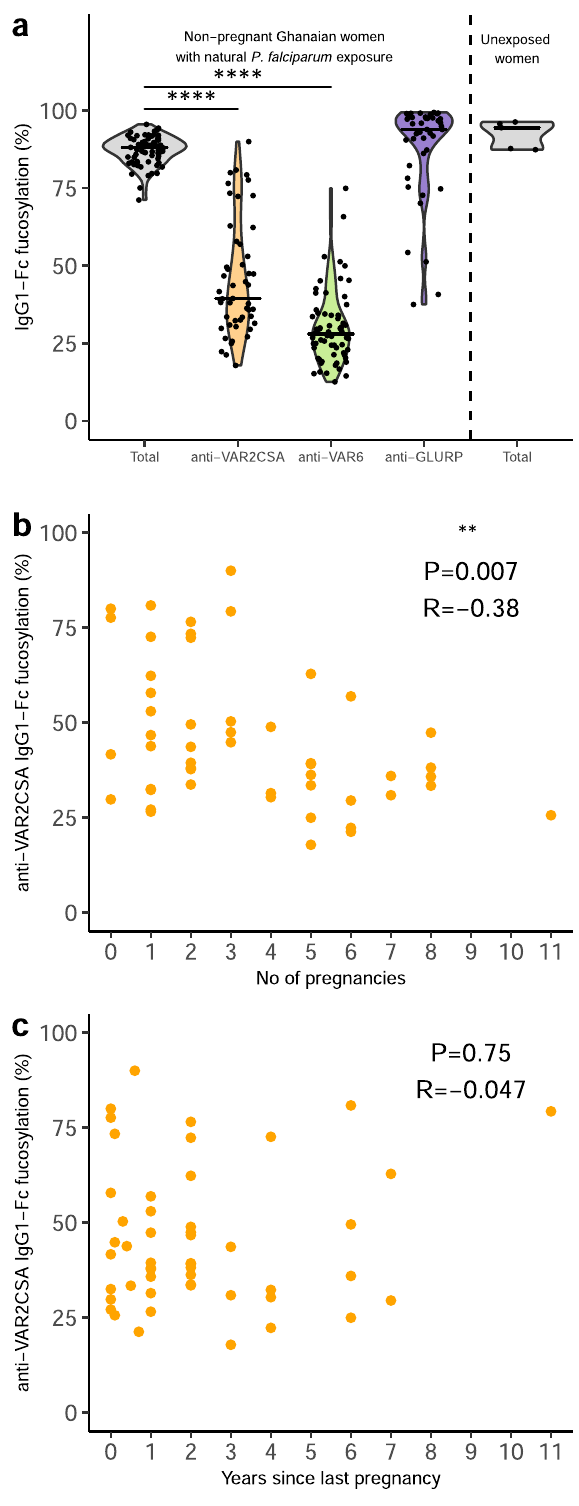
Fig. 3 Fc fucosylation levels of VAR2CSA-specifc IgG is temporally stable. a Fc fucosylation levels of total plasma IgG1 (gray, n = 72) and IgG1 with speci fi city for VAR2CSA (orange, n = 50), VAR6 (green, n = 65), and GLURP (blue, n = 43) in non-pregnant Ghanaian women exposed to VAR2CSA during one or more previous pregnancies. Fc fucosylation levels of total plasma IgG1 from unexposed Dutch females ( n = 5) are included as controls. Medians and densities are shown. Statistically signi fi cant pairwise differences between antigen-speci fi c IgG and total IgG (multiple two-sided Wilcoxon signed-rank tests with Bonferroni correction) are indicated (**** P < 0.0001). b Correlation between fucosylation levels of VAR2CSA- speci fi c IgG1 and parity. c Correlation between fucosylation levels of VAR2CSA-speci fi c IgG1 and time since last pregnancy. Statistical signi fi cance of correlations are shown (Spearman ’ s correlations. * P <